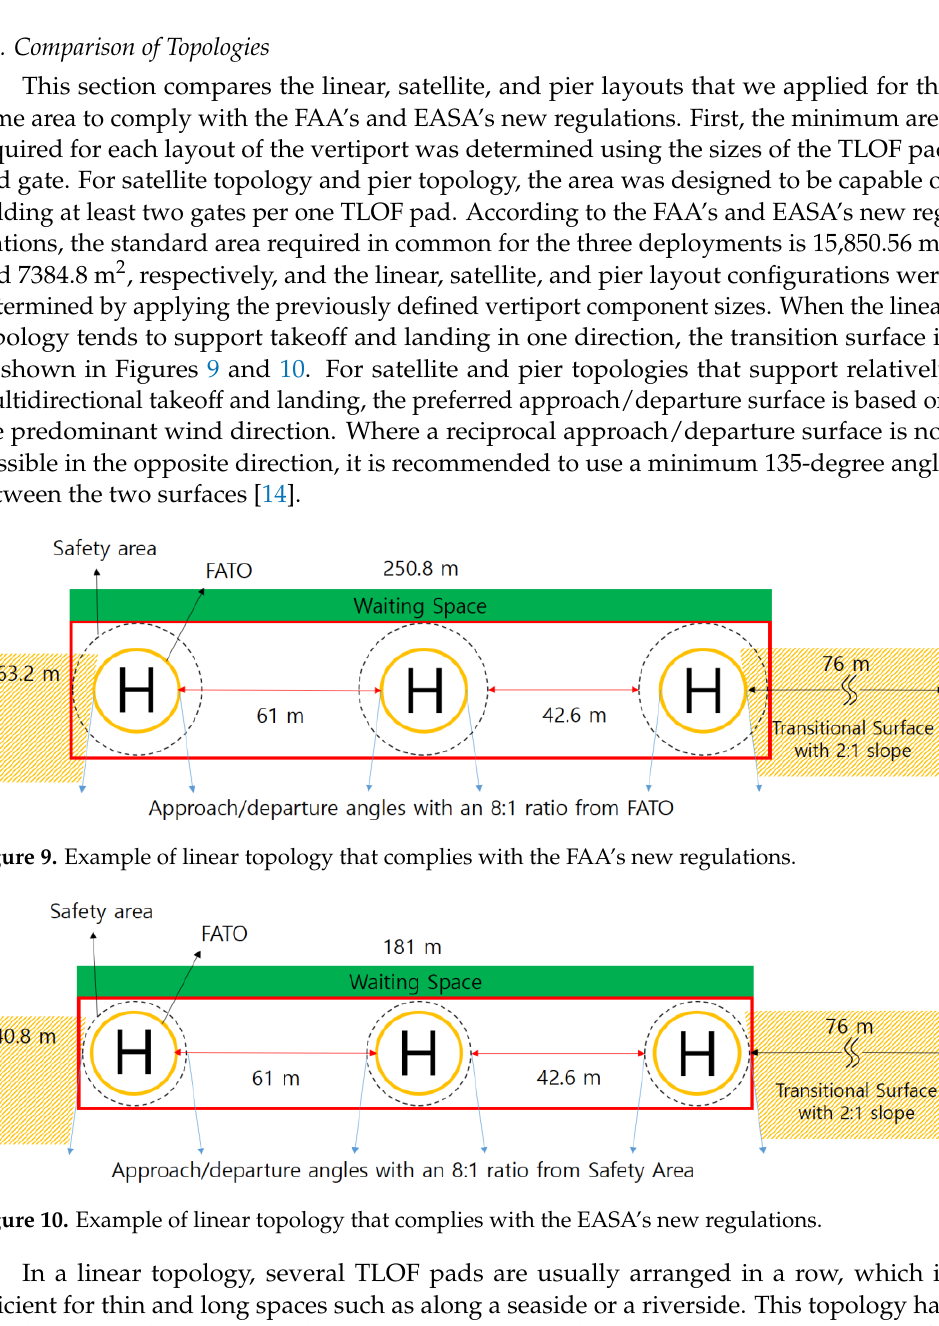
Figure 11. Example of satellite topology that complies with the FAA’s new regulations.